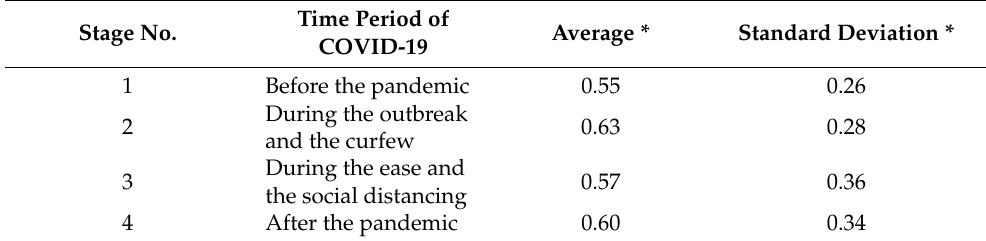
Table 3. The utilization of e-commerce and e-services in four periods. Time Period Stage No.